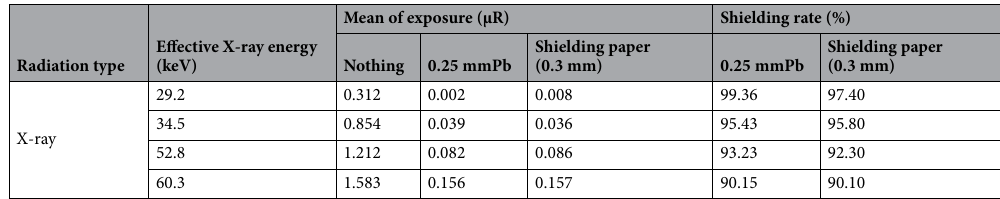
Table 4. Comparison of the shielding performances of a three-layer shielding paper and 0.25-mm lead plate.